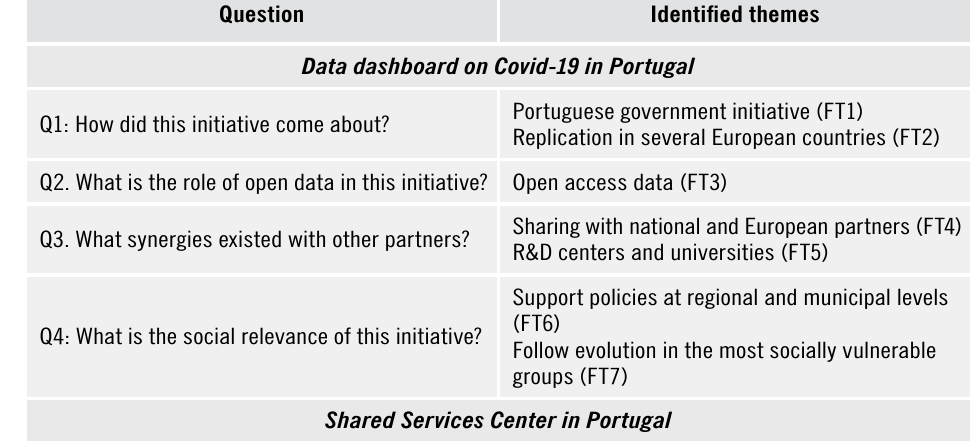
Table 4. Results of the thematic analysis